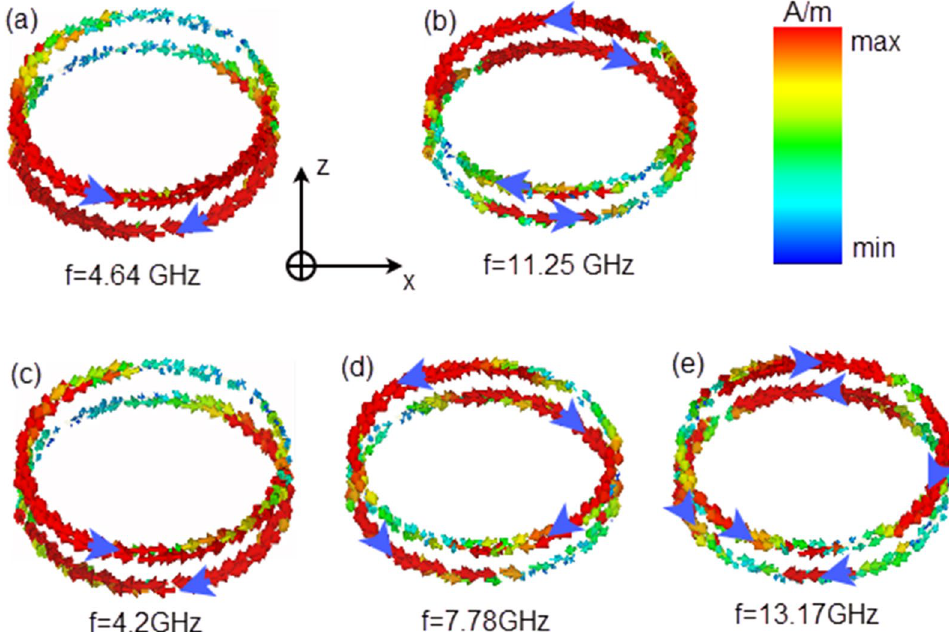
Figure 9. Surface current distributions. ( a ) and ( b ) are the reflected polarization resonances, and ( c ), ( d ) and ( e ) are the transmitted polarization